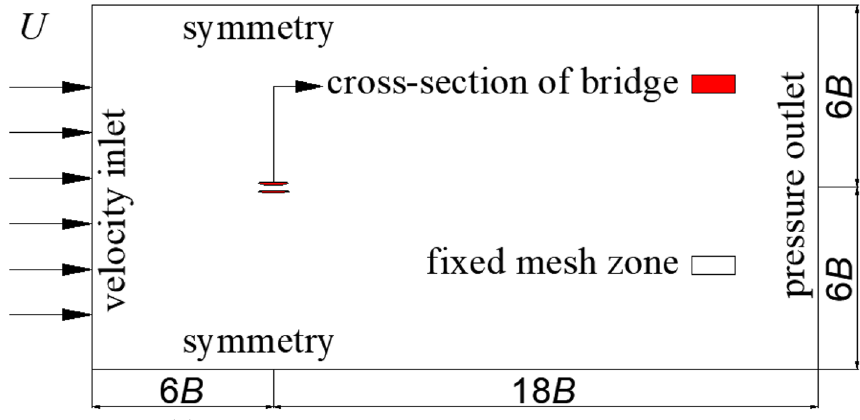
Fig. 2 Computational